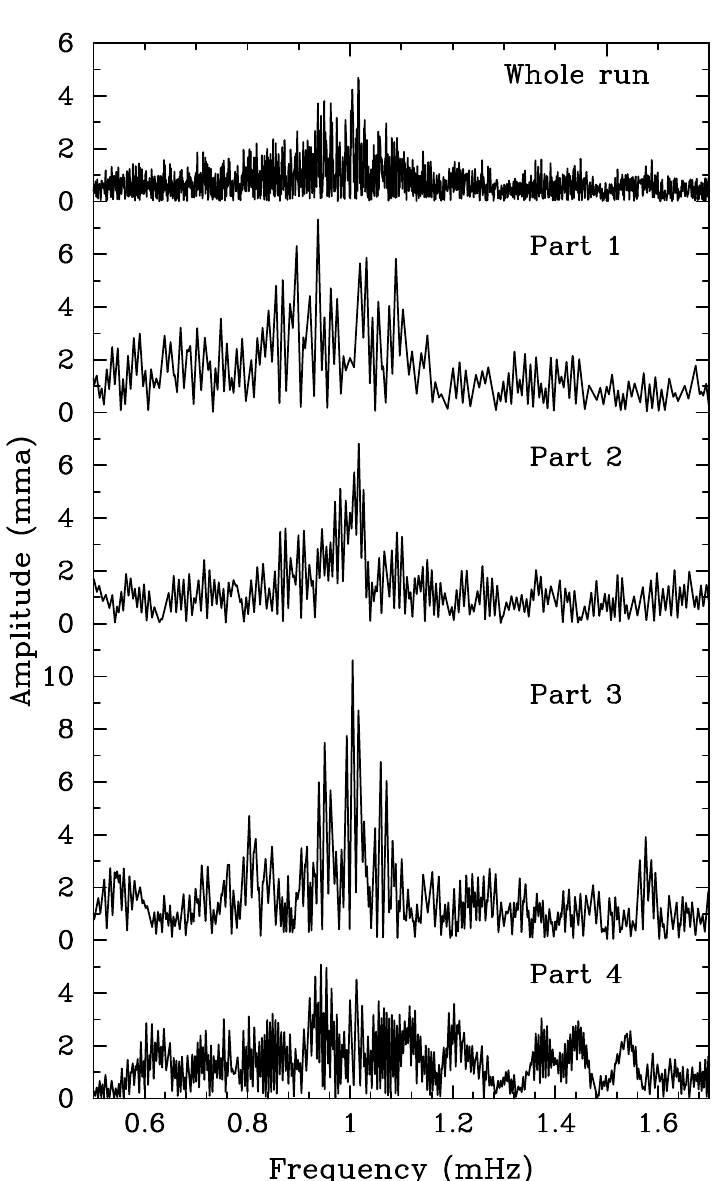
Fig. 1. Fourier amplitude spectra of the XCov7 observations of PG 1115+158. The upper panel is for the whole run; the following ones show four non-overlapping partitions of the data set. Note the strong temporal variability of the amplitude spectrum throughout the run. The amplitude spectrum in frequency regions not shown is consistent with